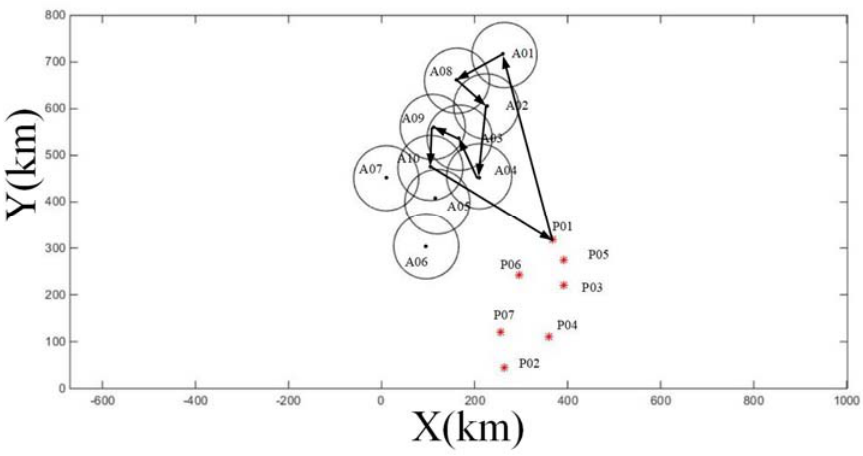
Figure 12. The flight path of the FY ‐ 2 No1 UAV.